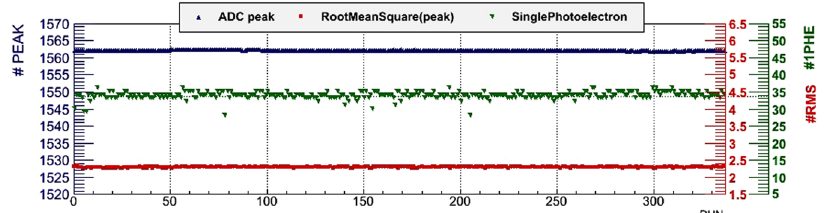
Figure 8. Stability of the main parameters acquired during pedestal runs, for one random channel, during the Mt. Echia data tacking: mean and RMS value of the ADC peak (blue triangles and red squares), the ADC mean value corresponding the single photoelectron response (green triangles). The drawing was obtained using the software root